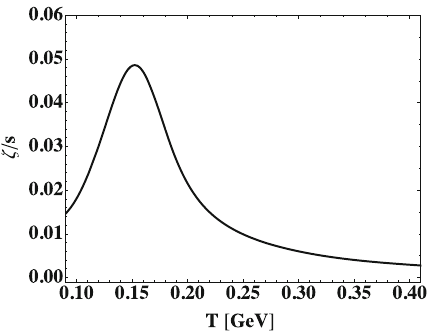
Fig. 1 Quasiparticle model bulk viscosity over entropy density as a function of temperature. For details concerning the method used to obtain this result see Refs.